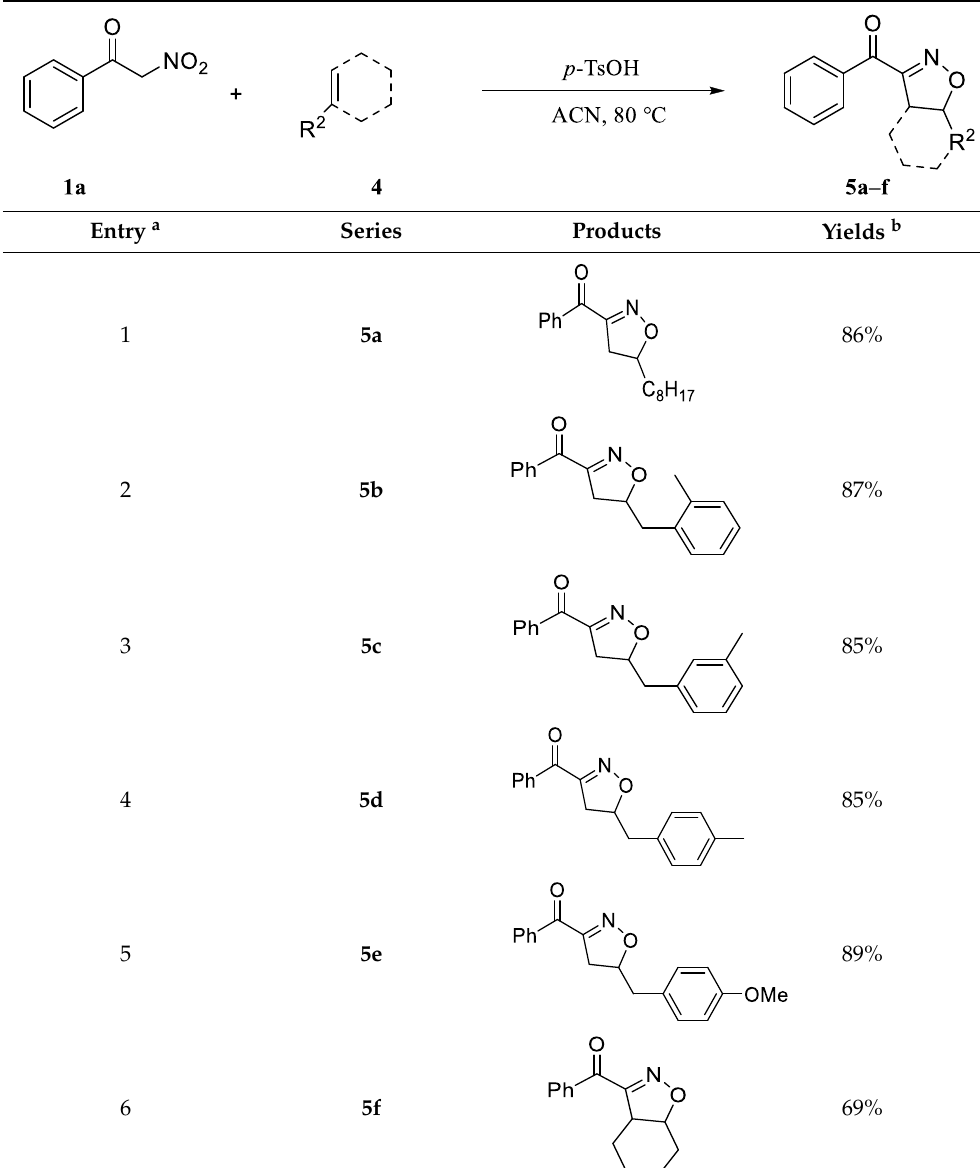
Table 2. Scopes of